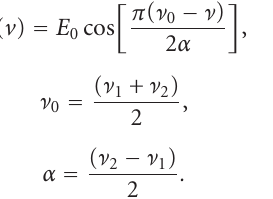
r = 1), nonmagnetic metamaterials coating represented